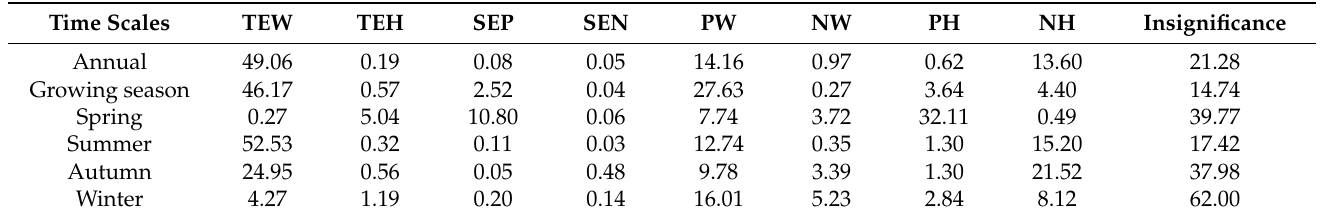
Table 4. Proportion of different function types for hydrothermal conditions affecting vegetation dynamics in Central Asia. (unit: